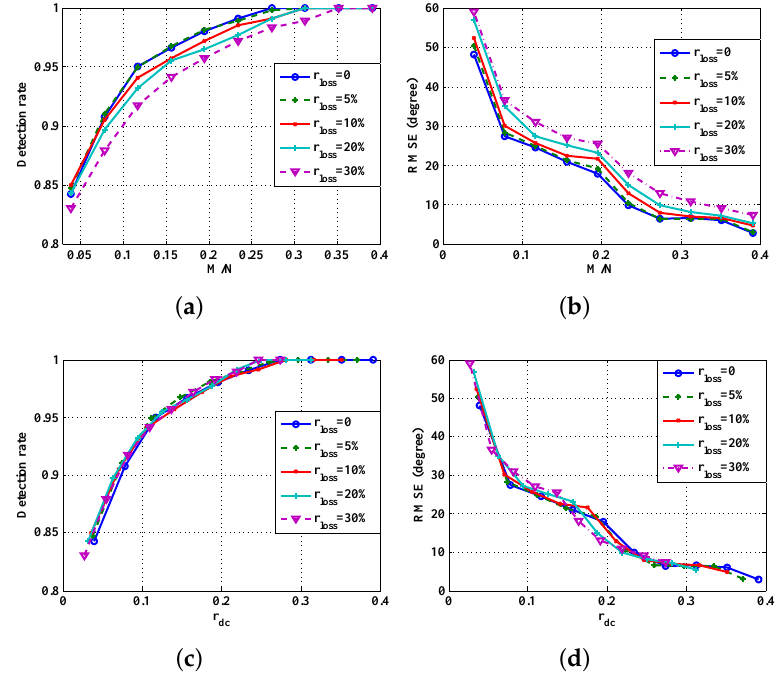
Figure 6. Comparison of different lossy transmissions: ( a ) Detection rate versus M / N ; ( b ) RMSE versus M / N ; ( c ) Detection rate versus r dc ; ( d ) RMSE versus r dc